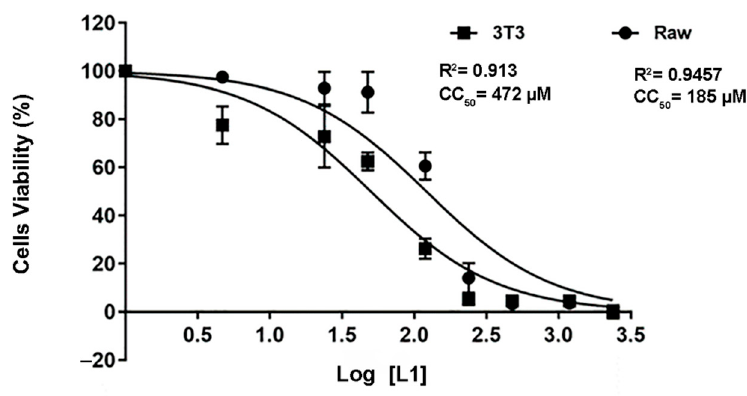
Figure 7. L1 evidence of the low toxicity to macrophage and fibroblast cell lines. The viability of 3T3 (fibroblasts) and Raw (macrophages) cells treated with L1 at different concentrations for 24 h was evaluated by the MTT method. The data are presented as the arithmetic mean and standard deviation (±). ANOVA and Dunnett’s post-test multiple comparisons were applied to determine the statistical significance between the different concentrations tested considering the value of p < 0.0001. Results are presented as the mean and standard derivation. Table 3. Selectivity index values of the L1 compound for the parasite and mammalian cell